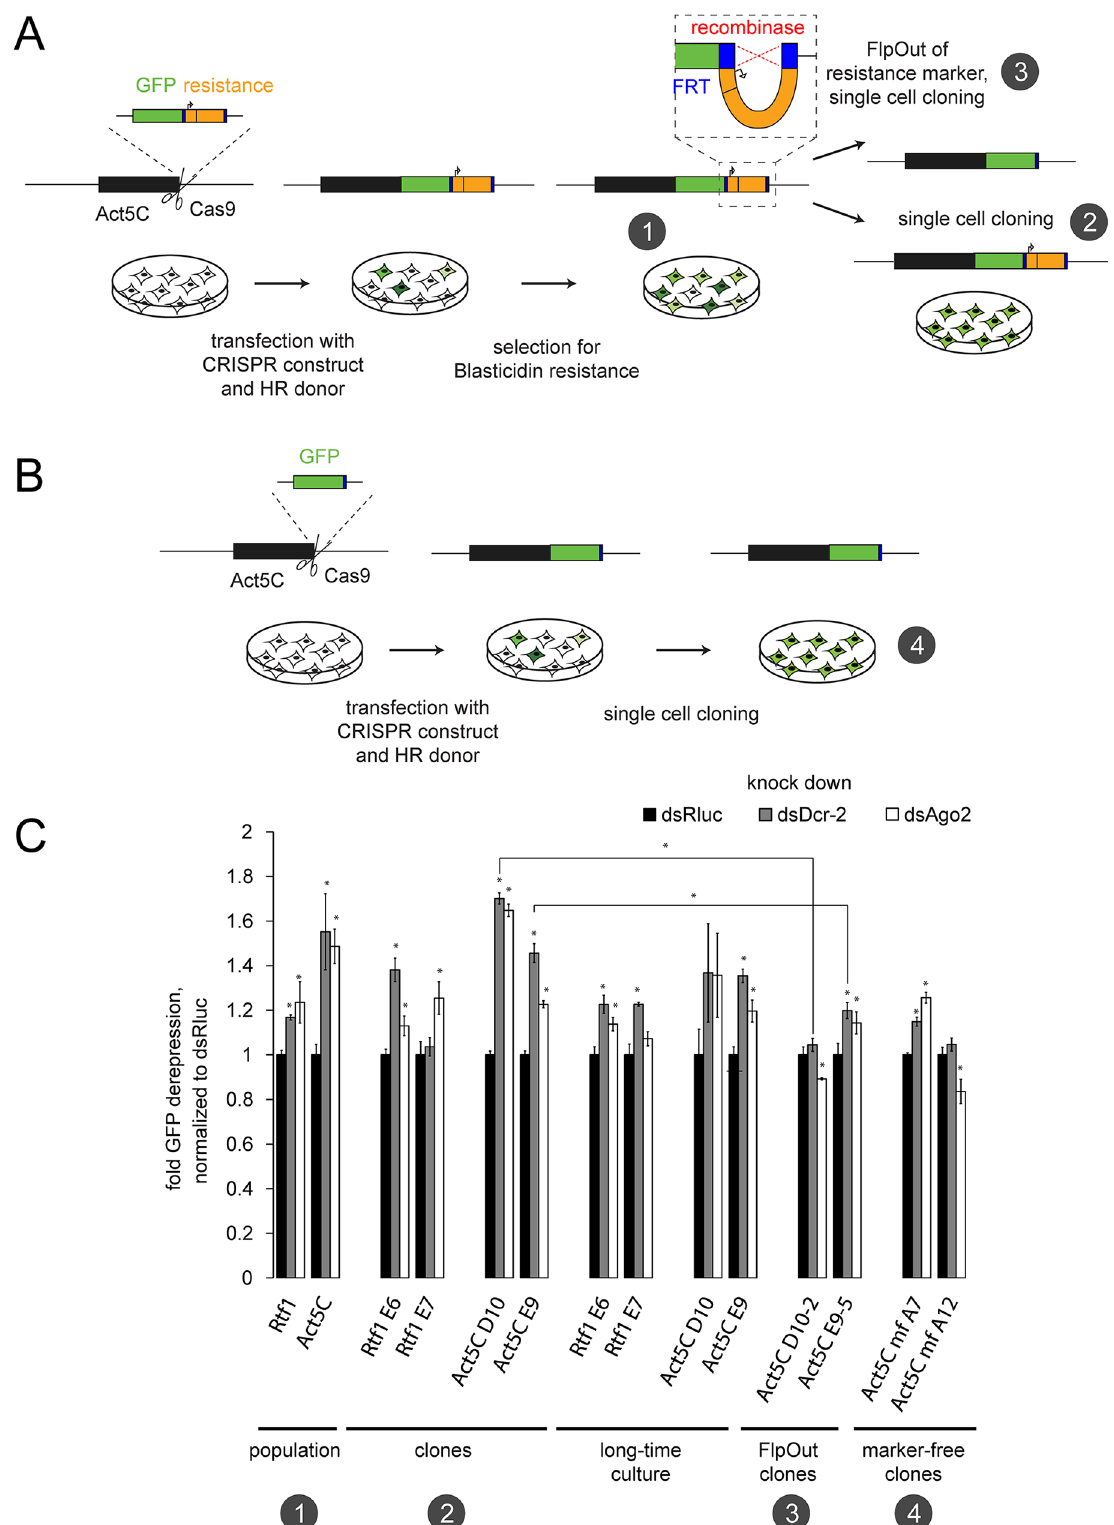
Fig 1. GFP-based reporter assay can detect siRNA mediated repression after genome engineering. (A) PCR-based taggingworkflowusing CRISPR/Cas9 in Drosophila Schneidercells. After introducinga DSB at the act5C locus by the Cas9